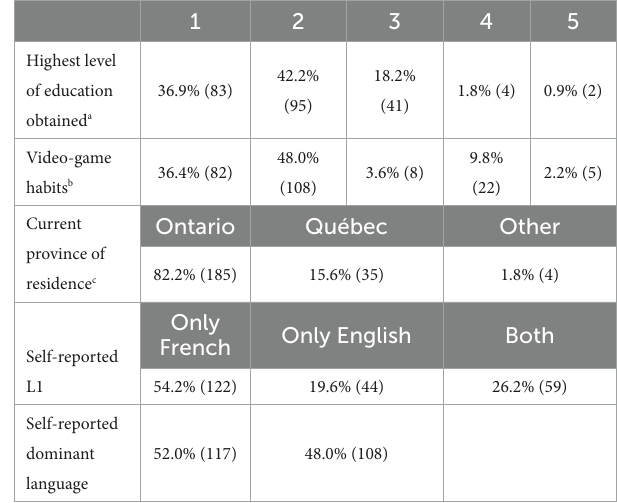
TABLE 1 Participant demographic background. Percentages indicated with n in parentheses.